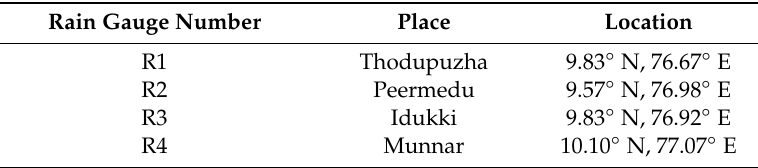
Table 1. Location of rain gauge